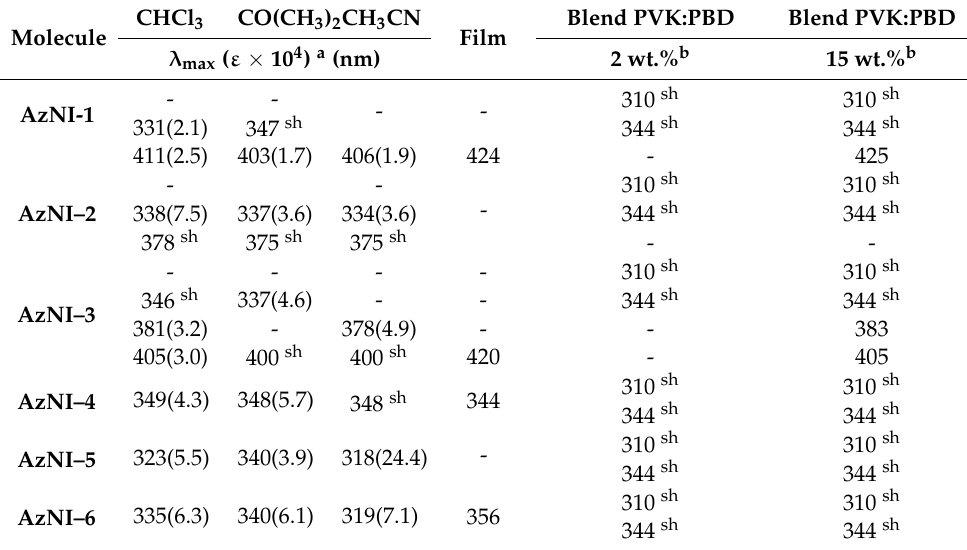
Table 3. UV-Vis absorption data of synthesized